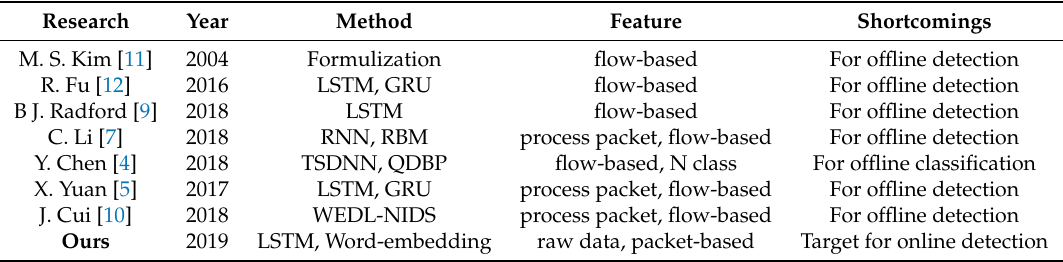
Table 1. Summary of several state-of-the-art relevant research works and our research location. (Notations: GRU: Gated Recurrent Unit; TSDNN: Shaped Deep Neural Network; QDBP: Quantity Dependent Backpropagation; WEDL: Word Embedding-based Deep Learning; NIDS: Network Intrusion Detection